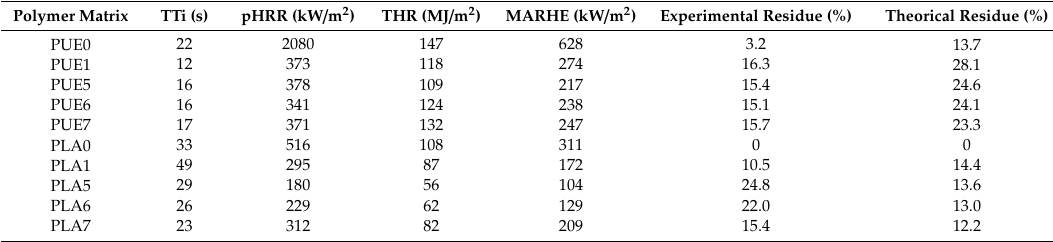
Table 7. Cone calorimeter results for PUE and PLA / APP / lignin composites. Polymer Matrix